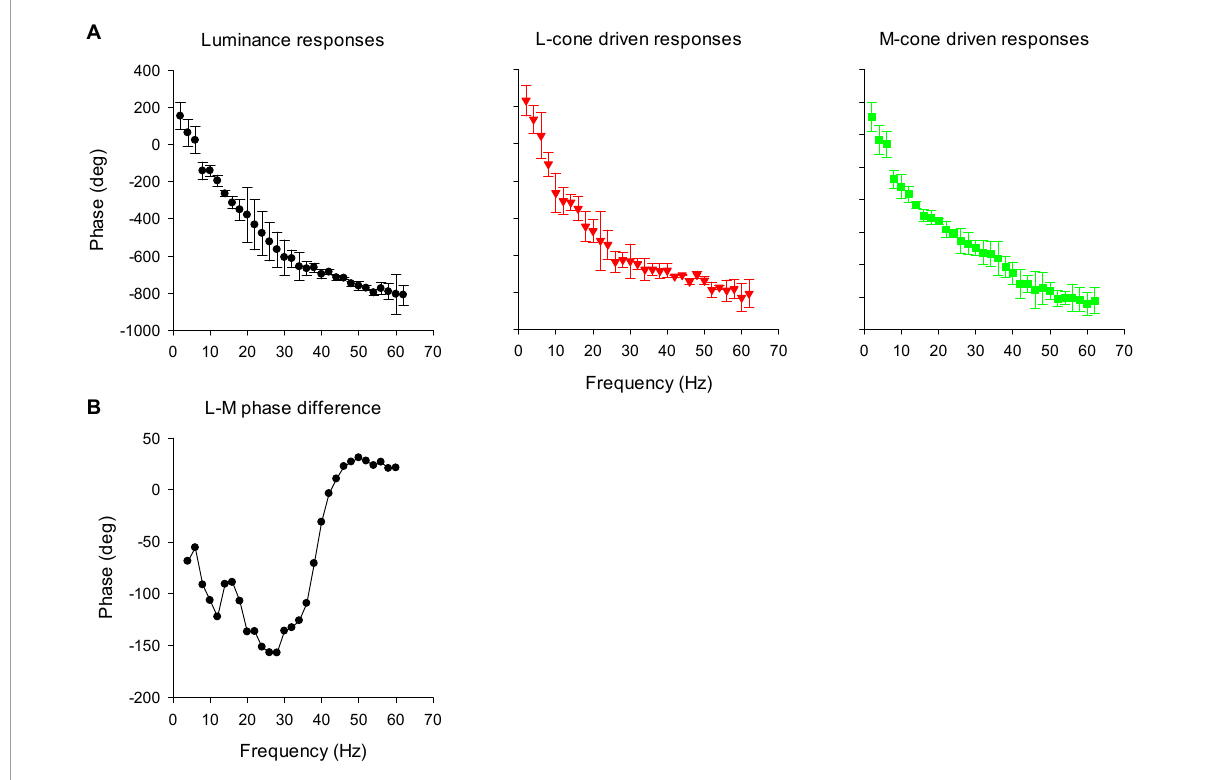
FIGURE13 (A) Phase plots of the IRFs (mean ± 1 SD) in the frequency domain after FFT (resulting in modulation transfer functions; MTFs). (B) The difference between L- and M-cone driven response phases, as a function of temporal frequency. The data were smoothed by averaging the phase difference at the indicated frequency with those at the two adjacent frequencies.